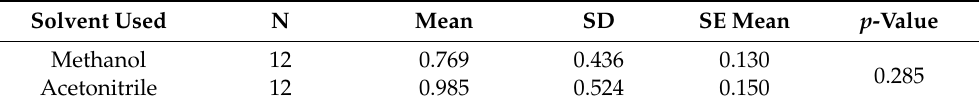
Table 4. Descriptive statistic for the 2-sample t -test. The table footnote shows the used hypotheses and the associated statistical parameters.